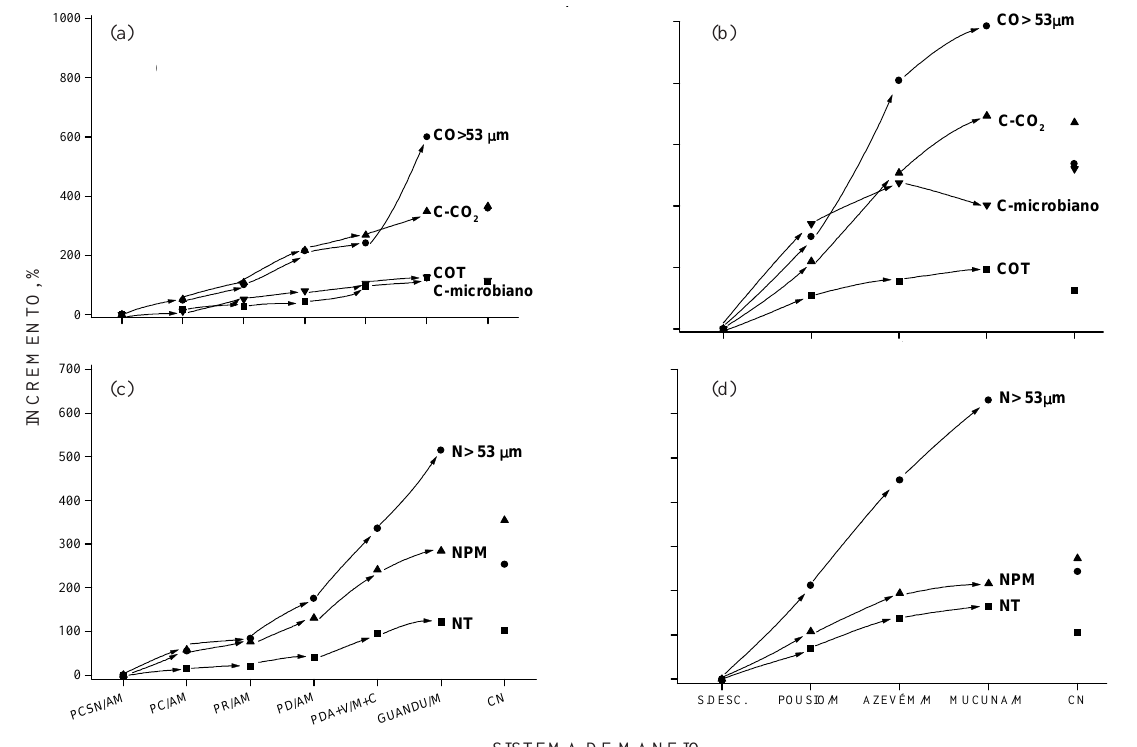
0100200300400500600700 53 µ m Figura 2. Incremento relativo do carbono orgânico total (COT), potencial de mineralização do carbono ), carbono da biomassa microbiana (C-microbiano), nitrogênio total (NT), nitrogênio no solo (C-CO 2 potencialmente mineralizável (NPM), carbono orgânico particulado (CO > 53 µm) e nitrogênio na fração particulada (N > 53 µm), na camada de 0–5 cm, sob diferentes sistemas de manejo, nas áreas experimentais da UFRGS e UFSM. O incremento relativo refere-se ao tratamento preparo convencional aveia/milho sem nitrogênio (PCSN A/M) na área experimental da UFRGS (a e c) e ao tratamento solo descoberto (S.DESC.) na área da UFSM (b e d). PC = Preparo convencional; PD = Plantio direto; A = aveia; M = milho; V = vica; C = caupi e CN = campo